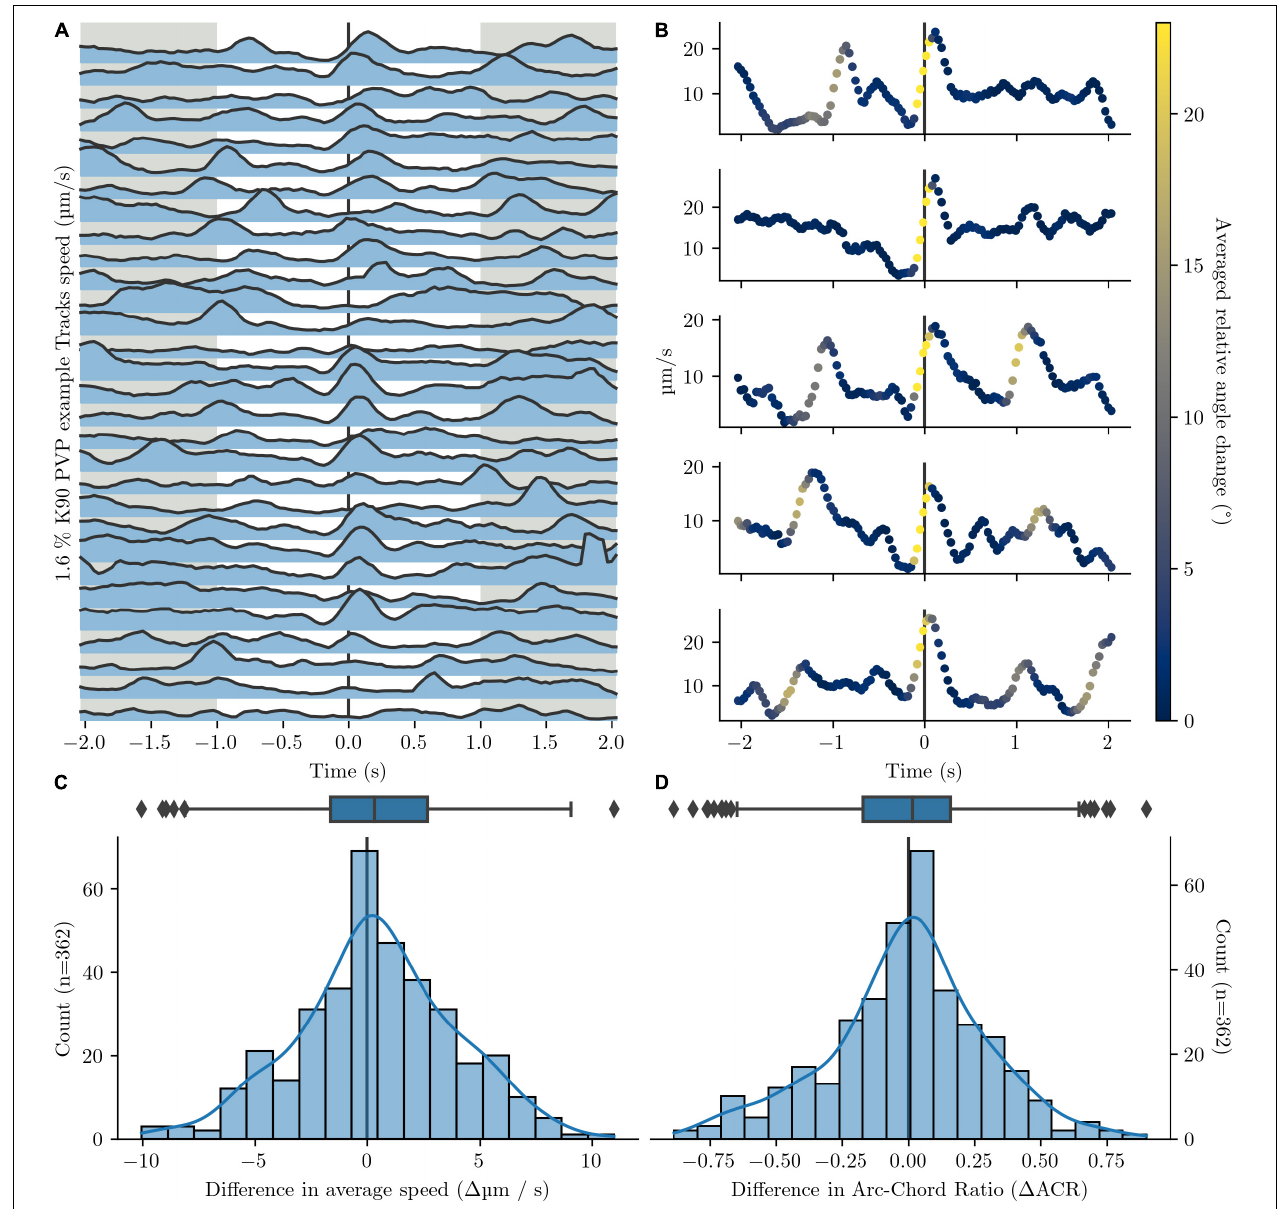
FIGURE 4 | Comparison of speed and arc-chord ratio before and after a turnaround. Events with more than one calculated turnaround within a 4 s window were excluded. Turnarounds are set to the point with local greatest change in angle. Tracks are from Figure 1C . (A) Speed profile of 30 example tracks before and after a turnaround (black line, T = 0). (B) Five additional detailed speed graphs before and after turnaround (black line, T = 0). The colouration indicates the relative angle change between positions. The speed maximum at or up to 0.5 s after the turnaround ranges between 16.3 and 27.2 µ m/s. (C,D) Histograms and corresponding box plots on the speed delta (C) and arc-chord ratio delta (D) before and after turnaround. The deltas are calculated between the time intervals [-2 s, -1 s] and [1 s, 2 s] (grey regions in A ) around the turnaround.